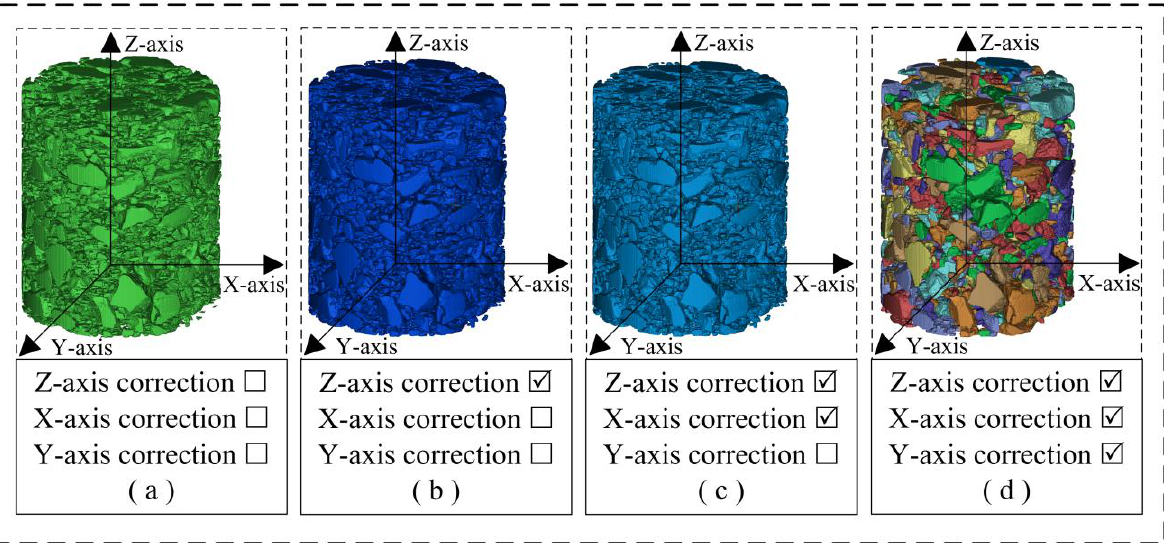
Figure 10. Three-dimensional voxel models at each stage of the improved procedure for 3D reconstruction: ( a ) Model A: obtained from 3D reconstruction of the CT slice set after 2D image segmentation; ( b ) Model B: Z-axis multiple correction completed on the basis of Model A; ( c ) Model C: X-axis multiple correction completed on the basis of Model B; ( d ) Model D: Y-axis multiple correction completed on the basis of Model C. Table 1. The main defects in the 3D model at each stage.